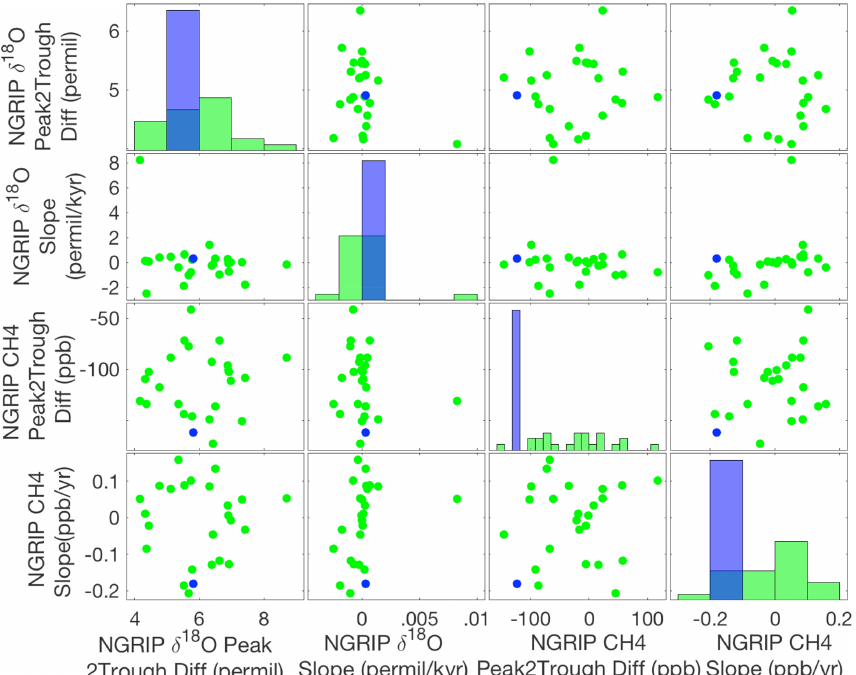
Figure 6. Greenland shape scatter grid. Of the 60 multivariate subsets analyzed for outliers, the above represents the essence of our results. Using both peak-to-trough stadial slope and measurements of NGRIP δ 18 O and CH 4 (left), we observe minimal outlier behavior from the BA/YD in each pair of the four-variable system, which indicates that the shape of the BA/YD’s Greenland records is not unique in of itself. Histograms along the diagonal plot the corresponding single-variable distribution; the horizontal location of the YD’s measurement is in purple on a normalized scale (i.e., the height of the purple bar is